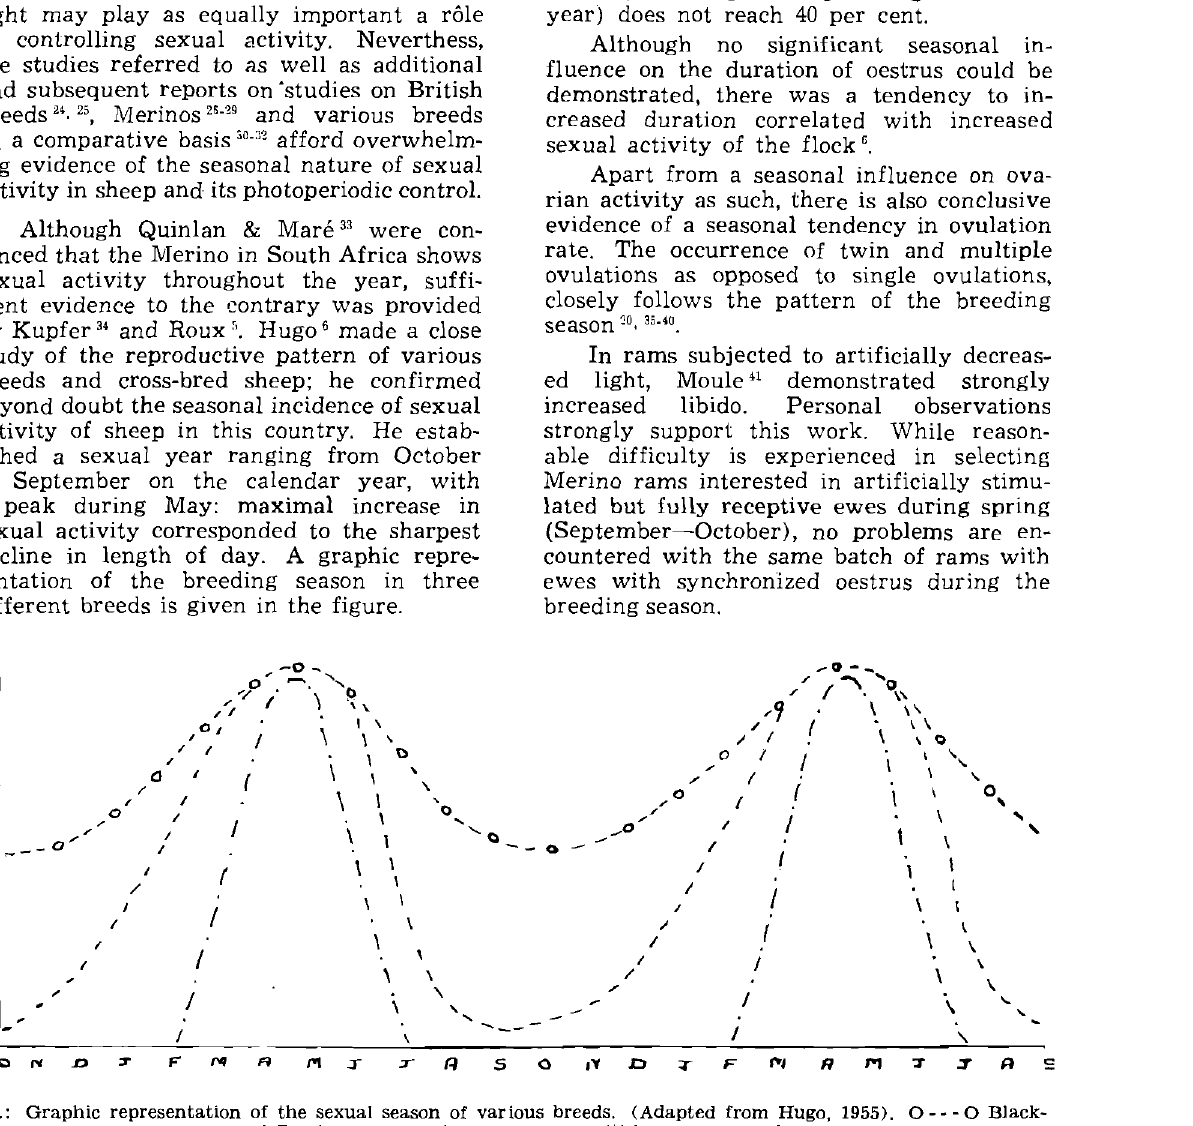
Fig.: Graphic representation of the sexual season of various breeds. (Adapted from Hugo, 1955). 0 -··0 Black head Persian. - - - Merino. - - - - - British mutton